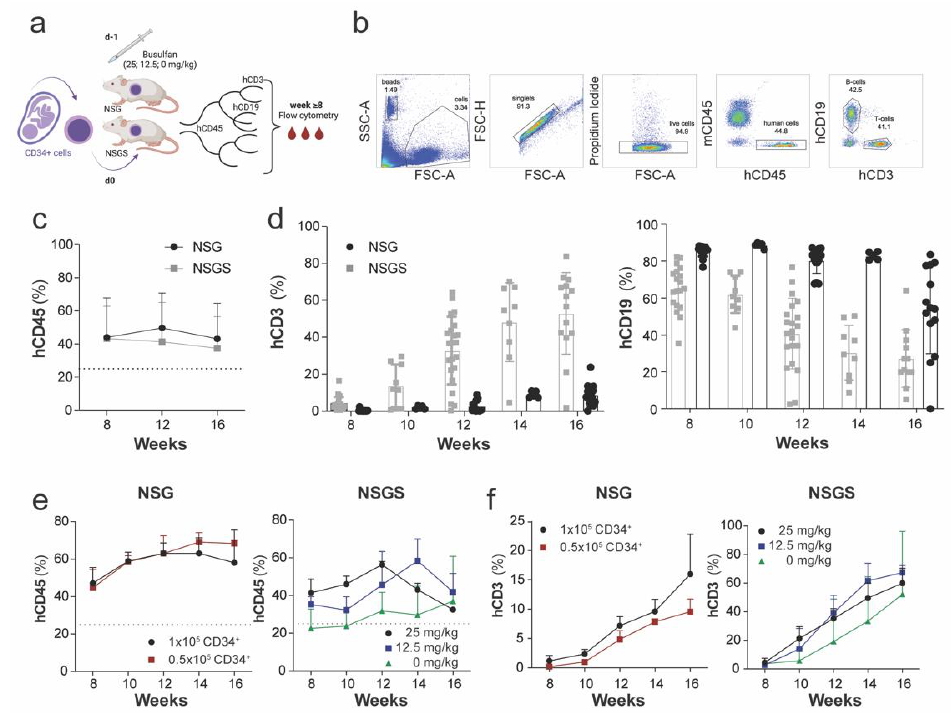
Figure 1. Reconstitution of the peripheral human immune system in NSG and NSGS mice. ( a ) Experimental design: Humanized NSG and NSGS mice were generated by preconditioning with different concentrations of busulfan at day –1, then 0.5–1 × 10 5 CD34 + cells isolated from the umbilical cord were injected intravenously on day 0. Blood samples were drawn regularly between week 8–16 post-engraftment. ( b ) Gating strategy used to define the level of chimerism and T cell development in mouse blood by flow cytometry. ( c ) Longitudinal measurement of human leukocyte frequency in NSG ( n = 26) and NSGS ( n = 26) mice. ( d ) Composite data of T cell (left) and B cell (right plot) development in representative NSGS mice ( n = 25) and NSG ( n = 15) over time. ( e ) Human leukocyte frequency was compared in NSG mice engrafted with 0.5 × 10 5 ( n = 3) and 1 × 10 5 ( n = 3) CD34 + cells and between different busulfan concentrations in NSGS mice ( n = 3/group). ( f ) Within the human CD45 + leukocyte population, the frequency of CD45 + CD3 + lymphocytes was determined.